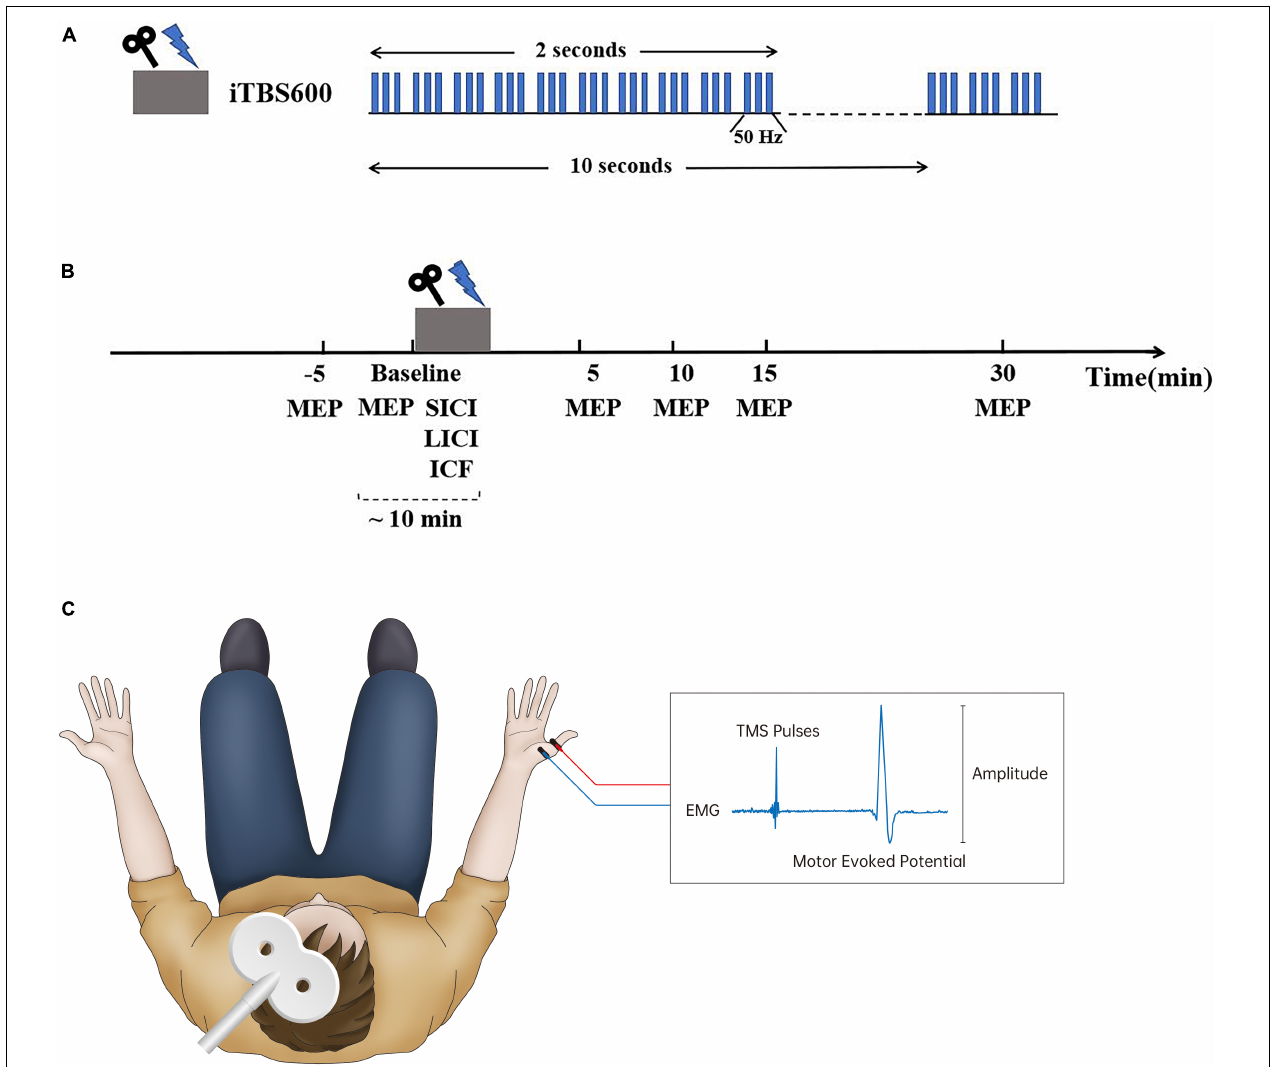
FIGURE 1 | Experimental design. (A) Intermittent theta burst stimulation (iTBS) protocol consisted of bursts containing three pulses given at 50 Hz and repeated every 200 ms; a 2-s train of this stimulating pattern was repeated every 10 s for a total of 190 s (600 pulses). (B) Each subject was assessed motor-evoked potentials (MEPs) and short-interval intracortical inhibitory (SICI), long-interval intracortical inhibitory (LICI), and intracortical facilitation (ICF) successively before iTBS intervention. Following iTBS, MEPs were assessed at 5, 10, 15, and 30 min after stimulation. (C) Transcranial magnetic stimulation (TMS) was performed over the hand region of the left primary motor cortex (LM1) connected with a figure-of-eight coil. The stimulating coil was placed tangentially to the scalp with the handle pointing posteriorly and laterally 45 ◦ to the sagittal plane over the LM1 region. MEPs were recorded from the right abductor pollicis brevis (APB) muscle by use